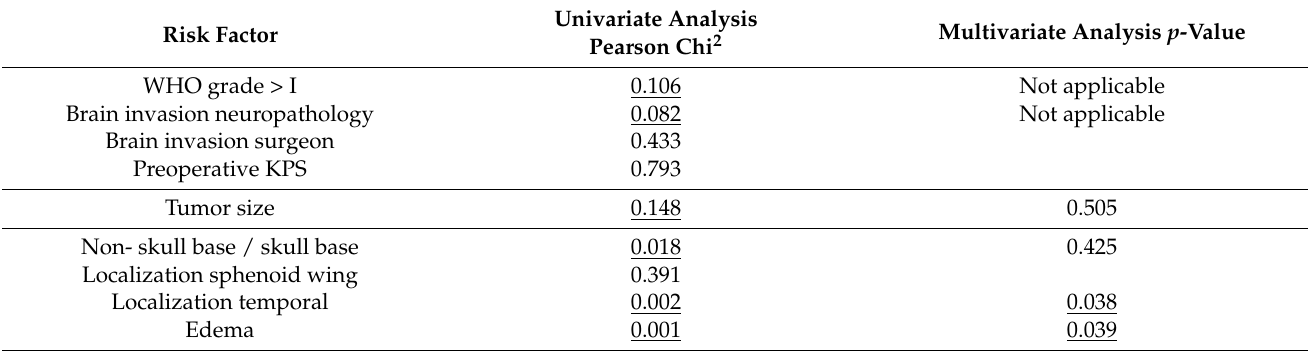
Table 3. Risk factors for preoperative